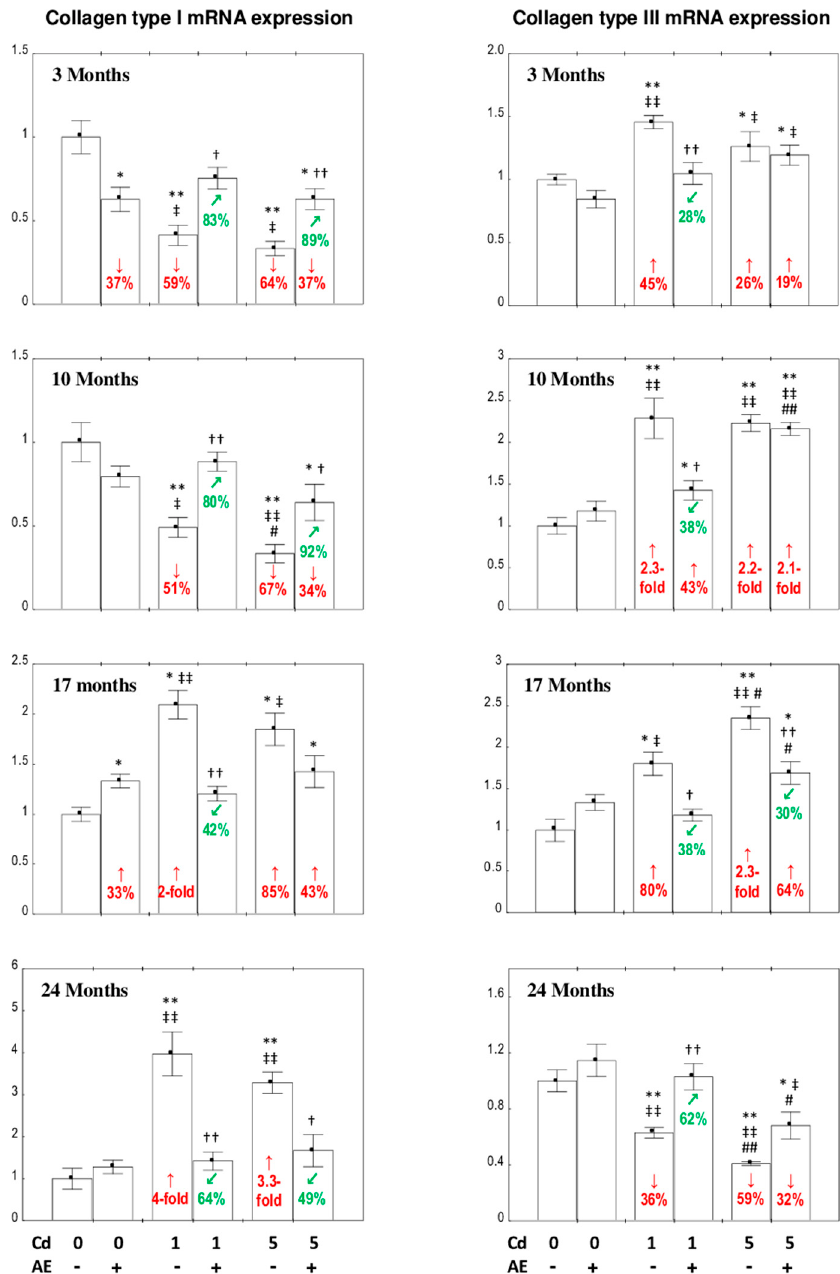
Figure 2. The impact of Aronia melanocarpa L. berry extract (AE) on the expression of collagen type I and collagen type III at the messenger ribonucleic acid (mRNA) level in the livers of rats exposed to cadmium (Cd). The animals were treated with Cd at the concentrations of 0, 1, and 5 mg Cd/kg in their diets and/or 0.1% aqueous AE (+) or not ( − ). Data are shown as mean ± SE for eight rats, except for seven animals in the AE, Cd 1 , and Cd 5 groups after 24 months. Statistically significant differences (Kruskal–Wallis post hoc test): * p < 0.05 and ** p < 0.01 vs. control group; † p < 0.05 and †† p < 0.01 vs. appropriate Cd group; ‡ p < 0.05 and ‡‡ p < 0.01 vs. AE group; # p < 0.05 and ## p < 0.01 vs. appropriate group maintained on the 1 mg Cd/kg diet (Cd 1 group or Cd 1 + AE group). Numerical values in bars express the percentage changes or factors of changes in comparison to the control group ( ↑ , increase; ↓ , decrease) or the appropriate group exposed to Cd alone ( ↗ , increase; ↙ , decrease).